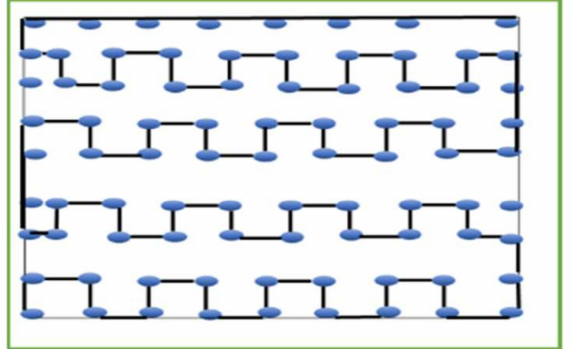
Figure 2. H-Curve path